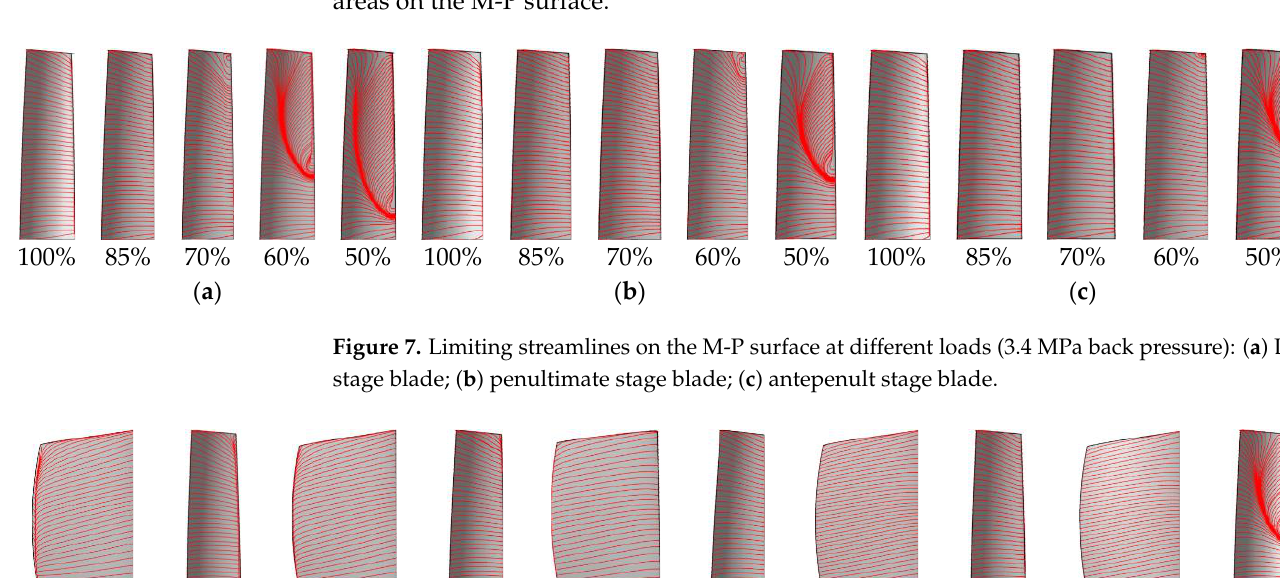
Figure 7. Limiting streamlines on the M-P surface at different loads (3.4 MPa back pressure): ( a ) Last stage blade; ( b ) penultimate stage blade; ( c ) antepenult stage blade .